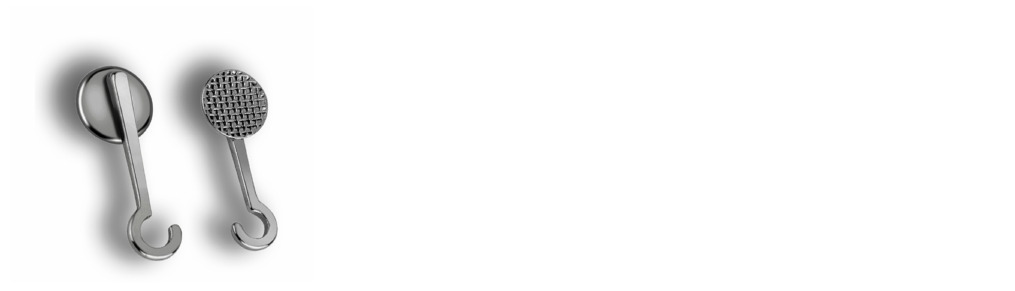
Figure 1. Example of common prefabricated metallic power-arms with a surface for attachment to a